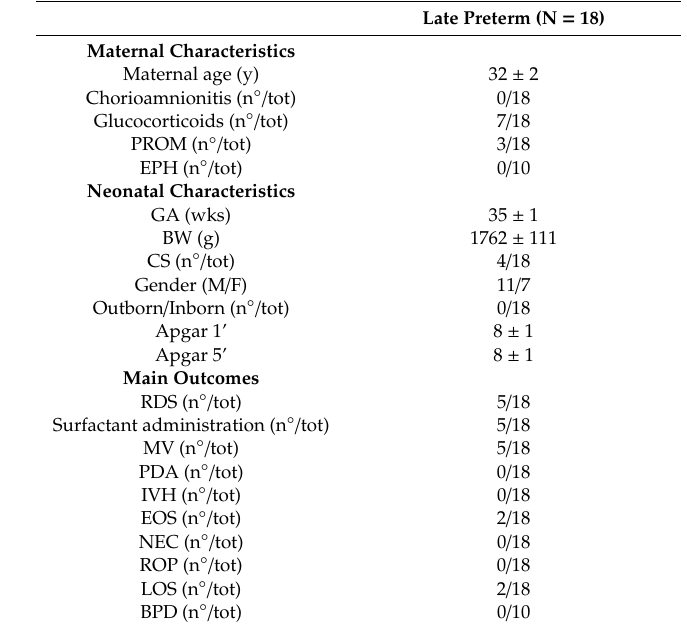
Table 1. Perinatal characteristics, main outcome measures and standard monitoring parameters recorded in late preterm infants. Data are given as mean ±